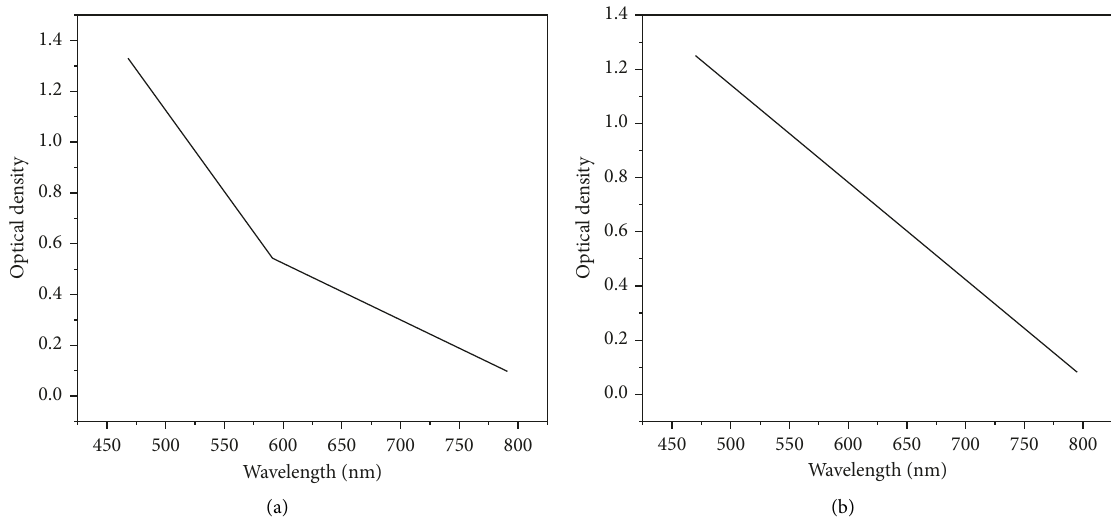
Figure 2: Absorption spectra of PMPI 3 films treated at different temperatures. (a) PMPI 3 /glass. (b) PMPI 3